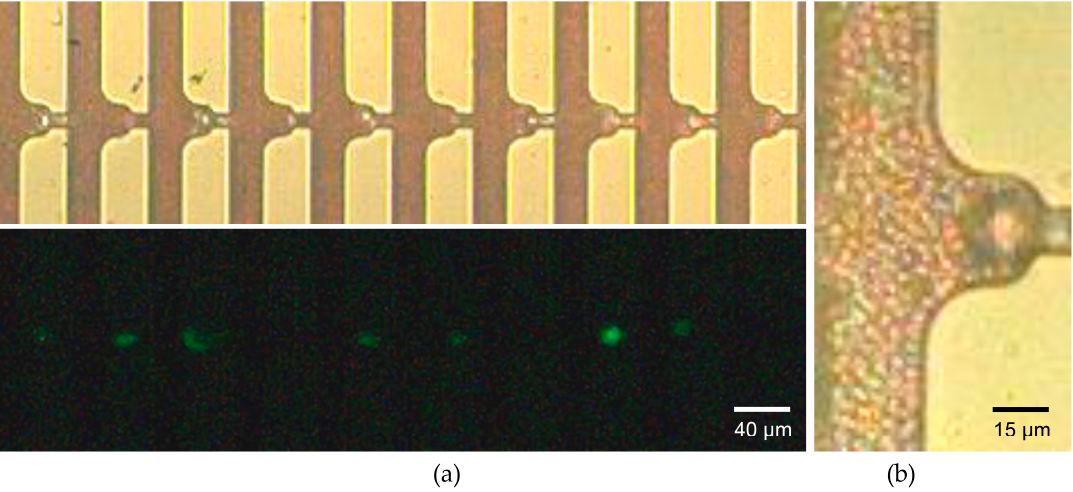
Figure 6. Demonstration of the whole blood processing using fVR trapping array: ( a ) bright field image and its fluorescent image of the individual tumor cell capture using a whole blood sample drawn from the metastasized mice; ( b ) magnified image of a single circulating tumor cell (CTC) capture using a two-fold dilution of the whole blood sample.